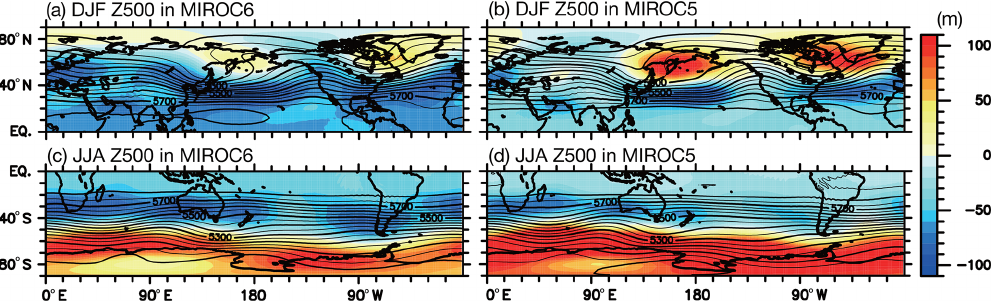
Figure 10. Same as Fig. 4, but for the wintertime 500hPa pressure level in MIROC6 (a, c) and MIROC5 (b, d) . Maps for boreal and austral winter are shown in (a, b) and (c, d) , respectively. ERA-I is used as observations.